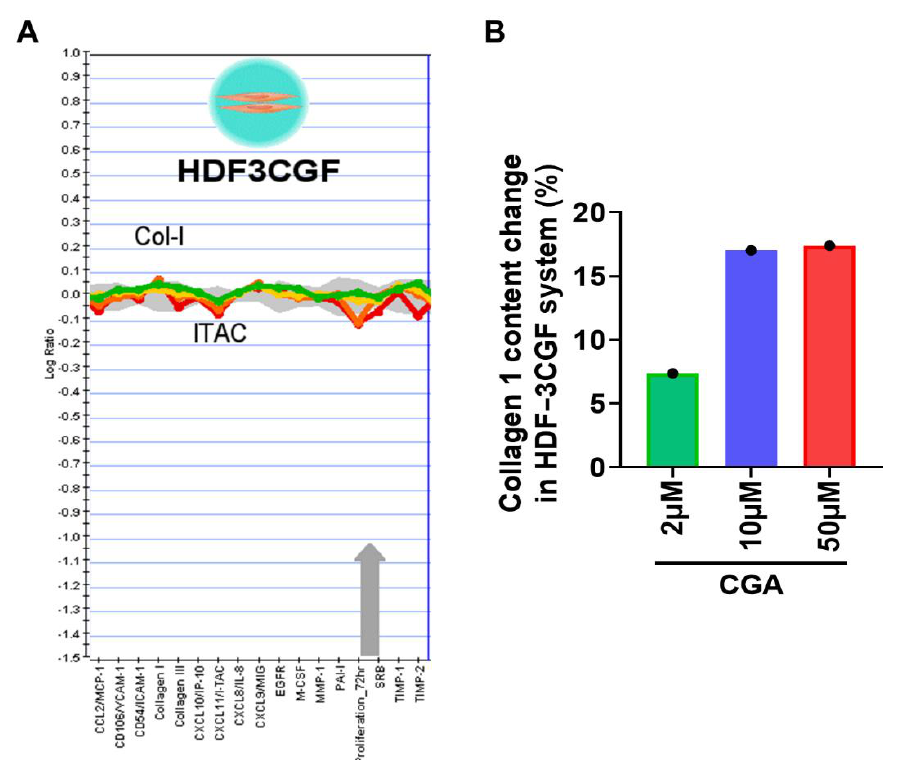
Figure 3. The effect of CGA on collagen I productions in HDFs. ( A ) The BioMAP HDF3CGF system was used to evaluate the effect of CGA on 16 biomarkers (proteins) involved in the tissue remolding and inflammation. ( B ) The relative increased percentages of collagen I after treatment with CGA were quantified and shown in the histogram.